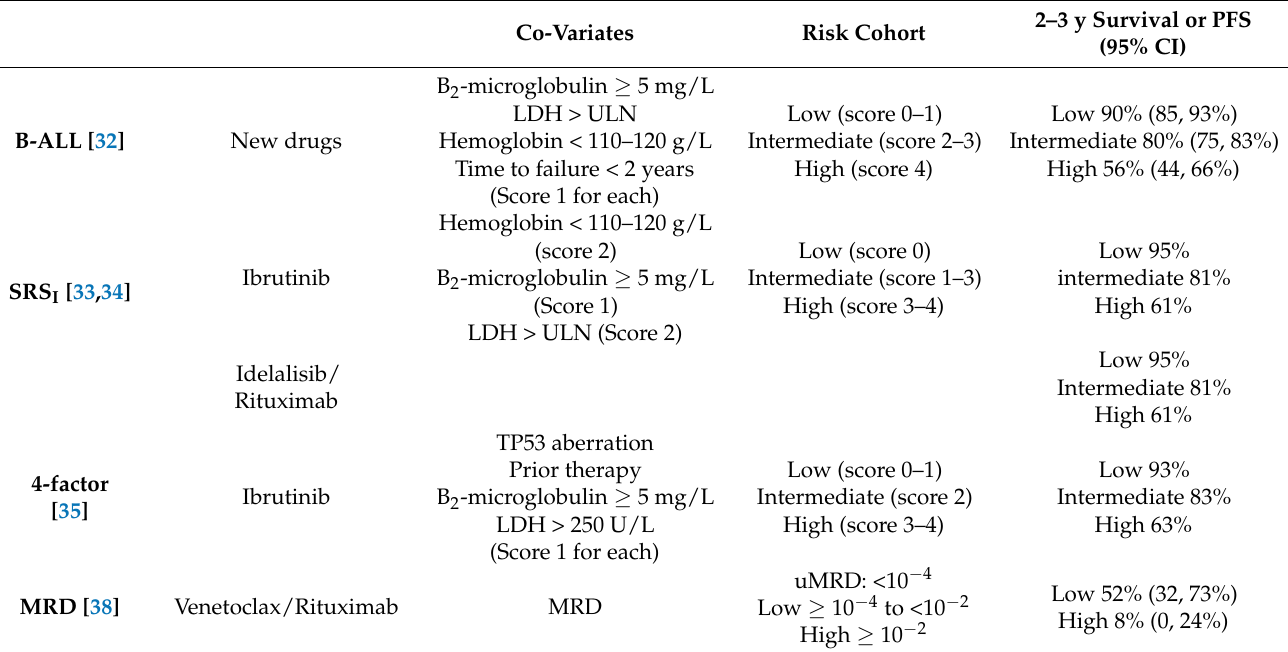
Table 2. Prognostic and predictive scores for persons with CLL receiving new drugs.